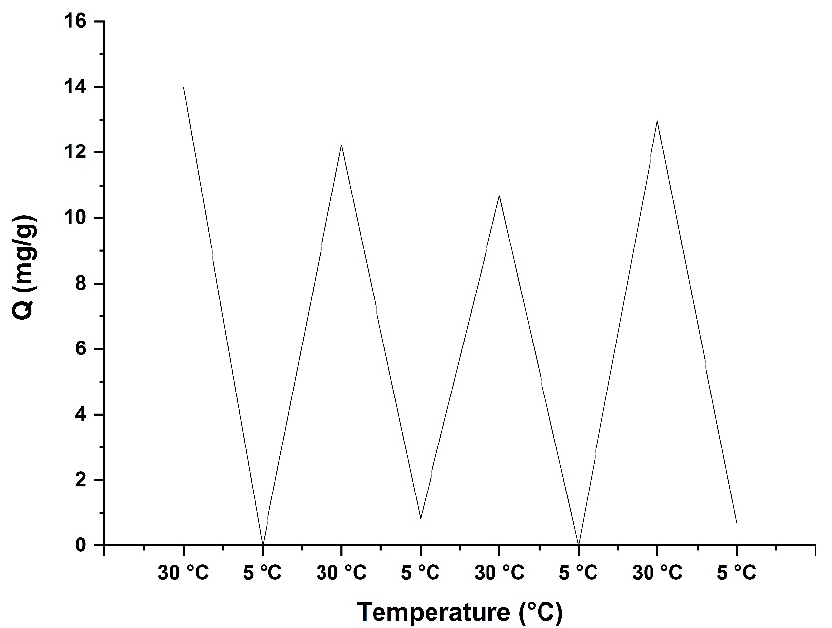
Figure 9. Reversibility of the temperature-induced protein binding and release. (1.6 mg/mL Lys- PMNP was incubated with 50 µg/mL lysozyme in 50 mM PB, pH 7).